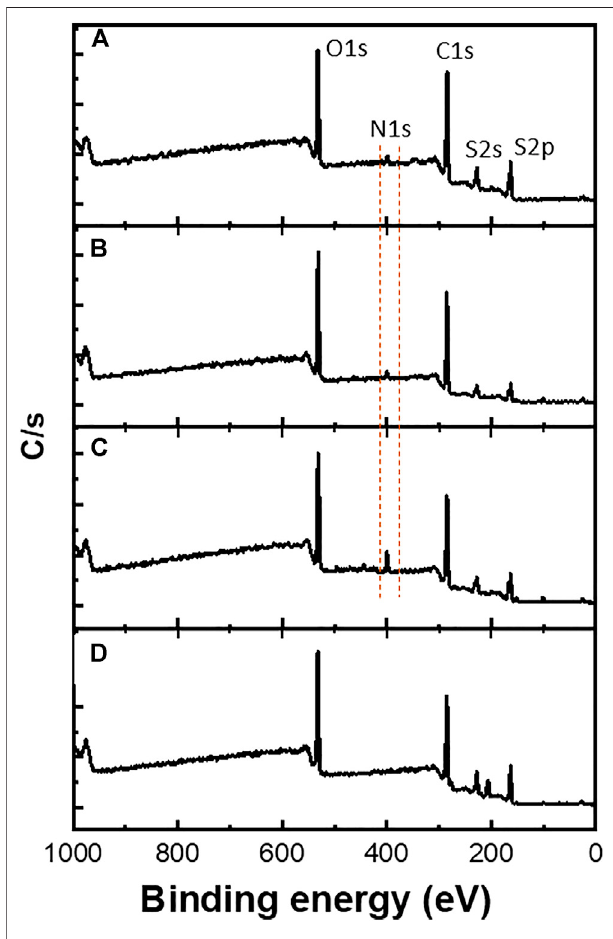
FIGURE4 | XPS spectra ofpolymer fi lmselectrodeposited on ITO-glass slides.ThedottedlineindicatesthecharacteristicNatompeak observedfrom poly(EDOT-BG) (C) , poly(EDOT- co -EDOT-BG) (B) , and poly(EDOT-EG4- co - EDOT-BG) (A) fi lms that con fi rmed the successful copolymerization. (D) represents PEDOT spectrum as a